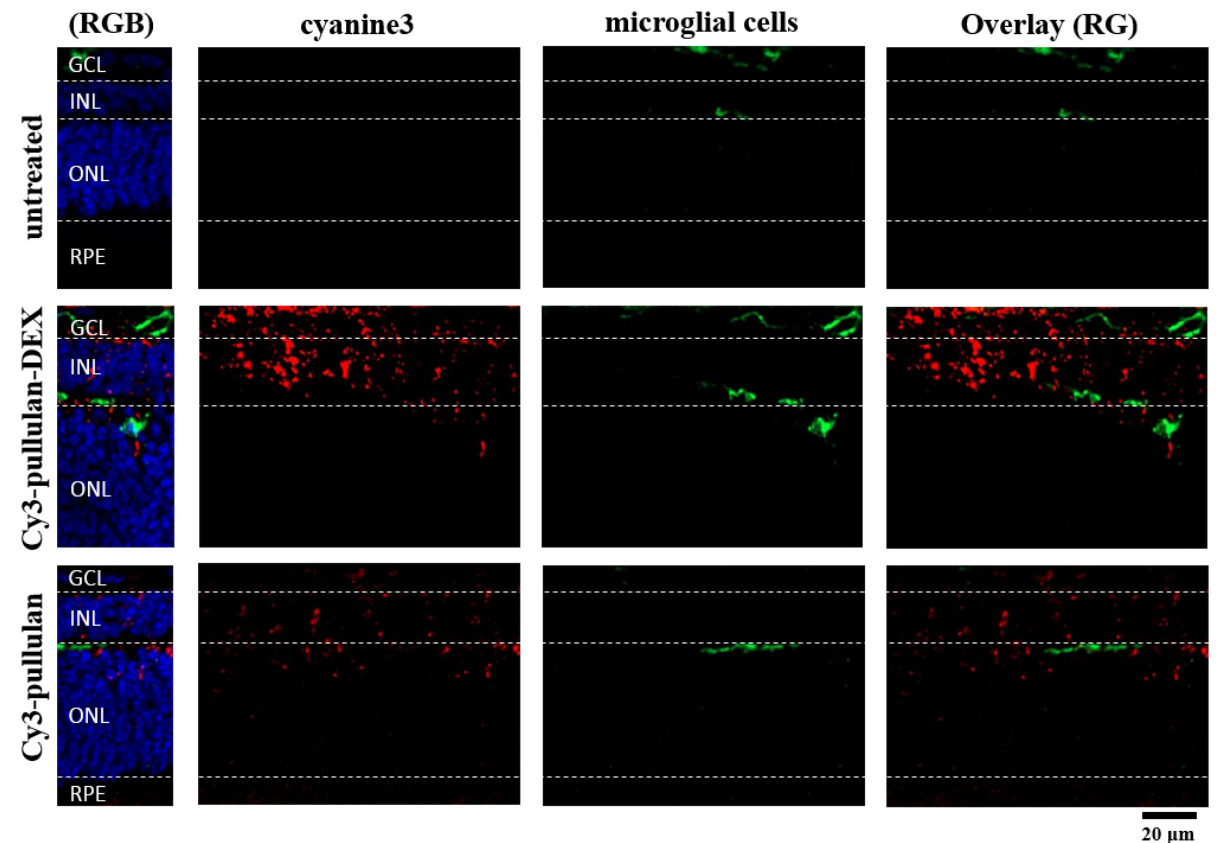
Figure 10. Microglial cells in sections of the ex vivo mouse retina labelled with an antibody against Iba-1 (green). Untreated retina, retina treated with Cy3-pullulan-DEX (15 µ L, 1.9 mg/mL) and Cy3-pullulan (15 µ L, 1.7 mg/mL) are shown. Cy3 fluorescence is shown as red. Nuclei were stained with DAPI (blue). RG: overlay of red and green channels for microglial cell, nanoparticle or conjugate colocalization. RGB: overlay of red, green and blue channels. Bar size: 20 μ m.